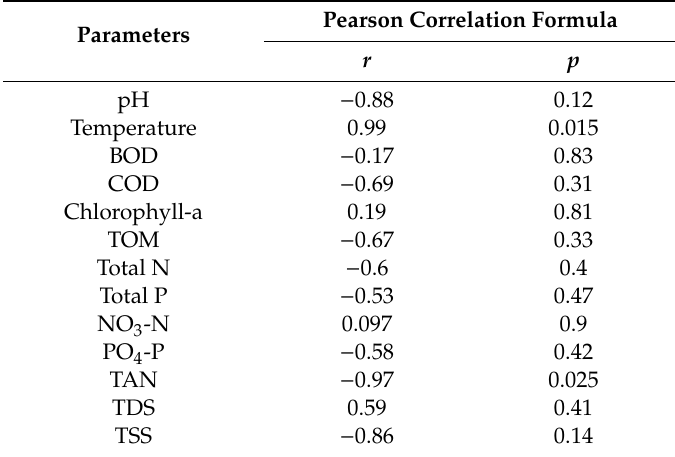
Table 2. Pearson correlation between the abundance of Pseudomonas and environmental parameters. r indicates Pearson correlation.